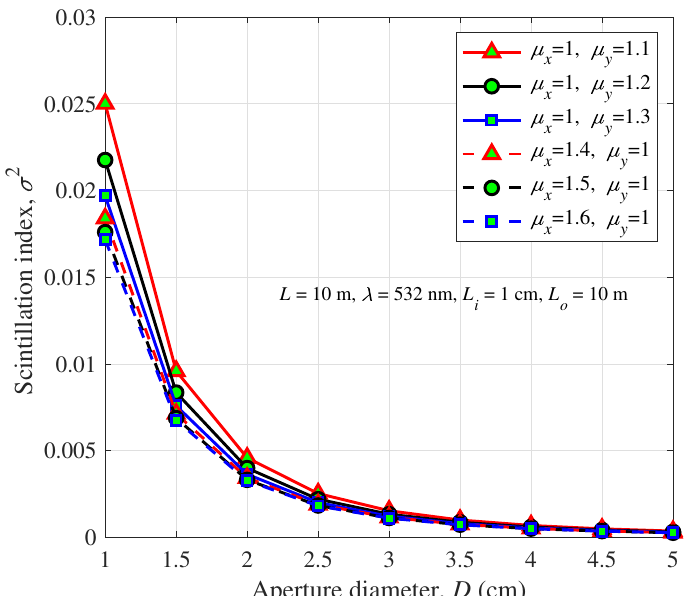
Figure 9. Scintillation index of a spherical wave versus the receiver aperture diameter for different anisotropic